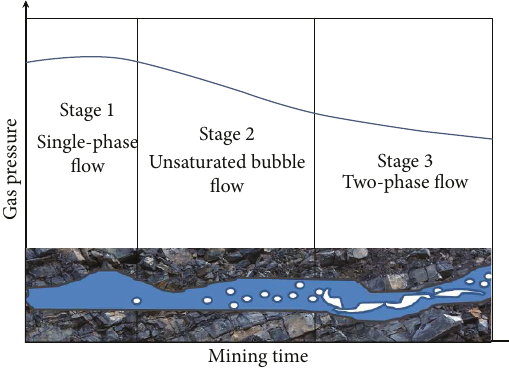
Figure 1: Process of shale gas